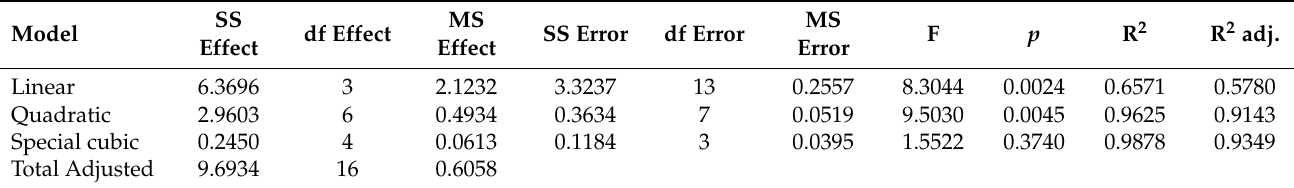
Table 3. ANOVA analysis for linear, quadratic and special cubic